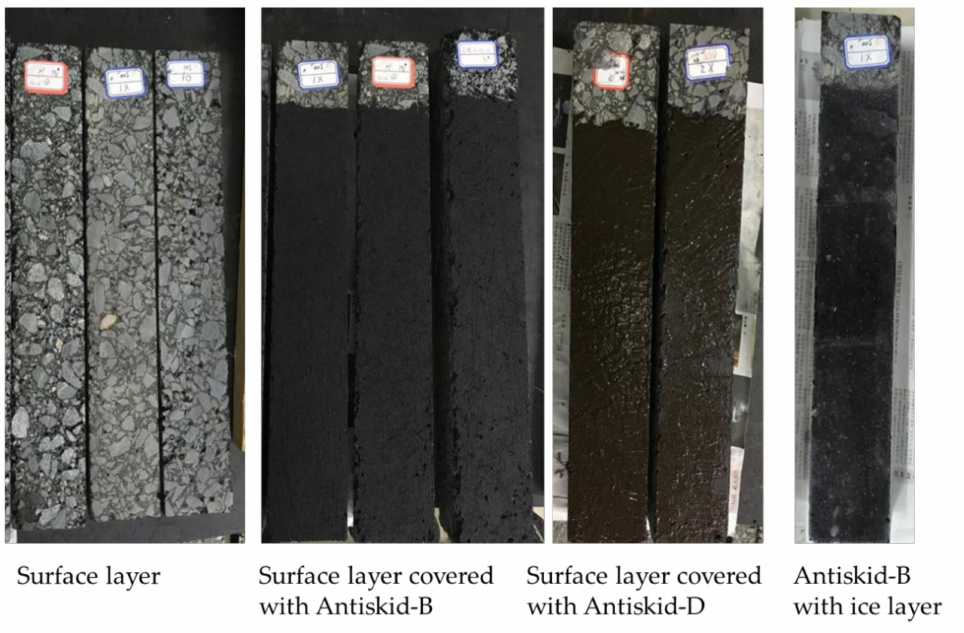
Figure 1. Visual feature of the investigated surfaces.